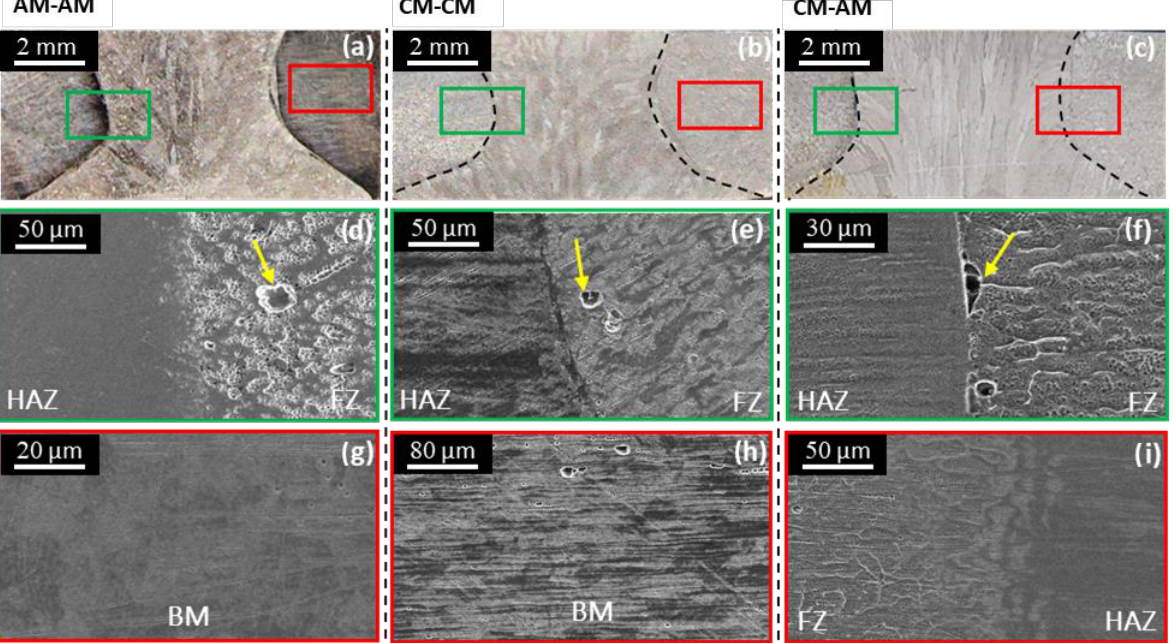
Figure 11. Microstructure of cross-section of welded samples: ( a – c ) higher magnification of welded cross sections, ( d – f , i ) fusion zone (FZ) and heat-affected zone (HAZ), ( g , h ) conventional and additive manufacturing base material.